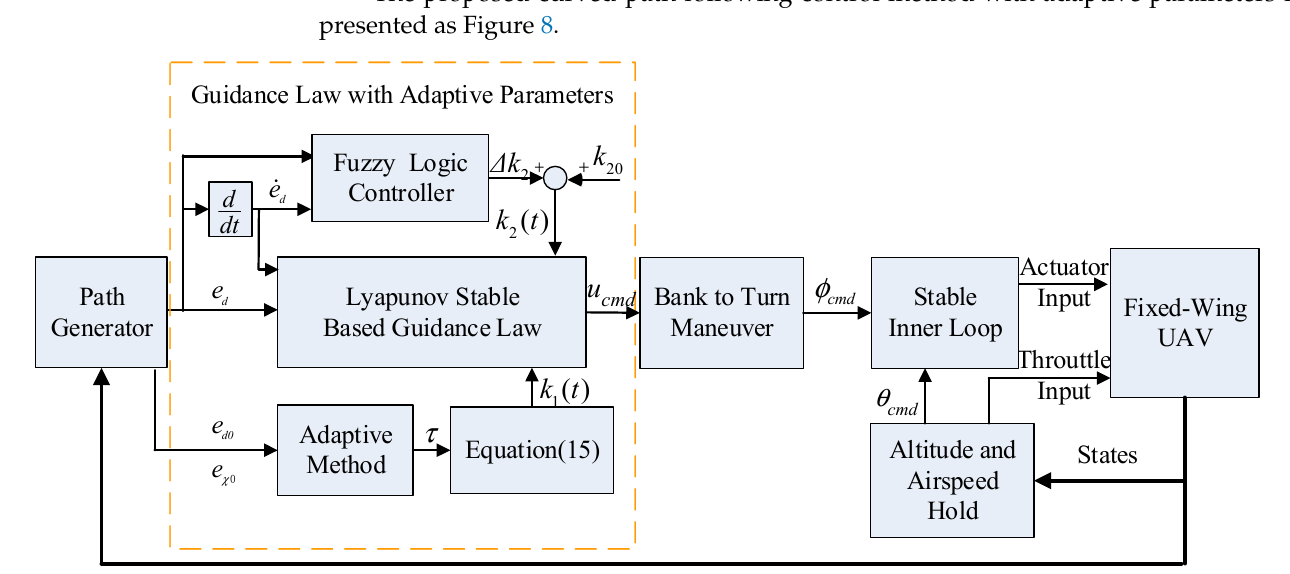
Figure 8. The structure of the proposed controller.